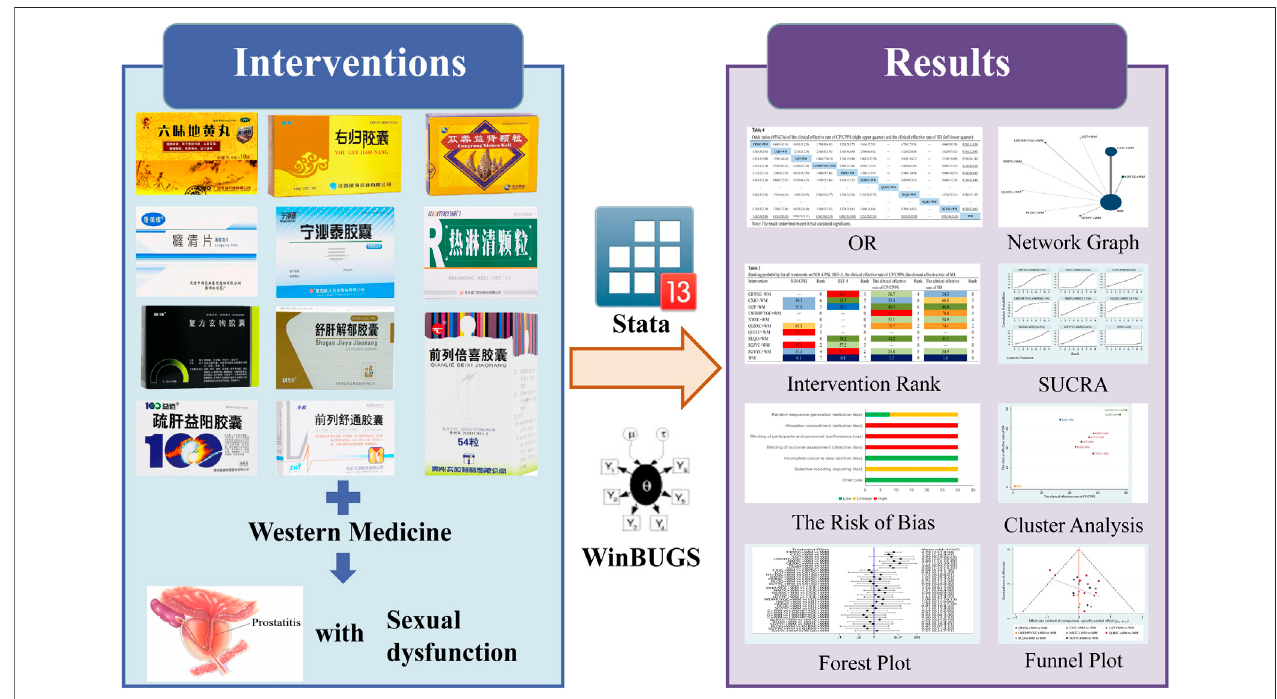
FIGURE 1 | Graphic work fl ow for the